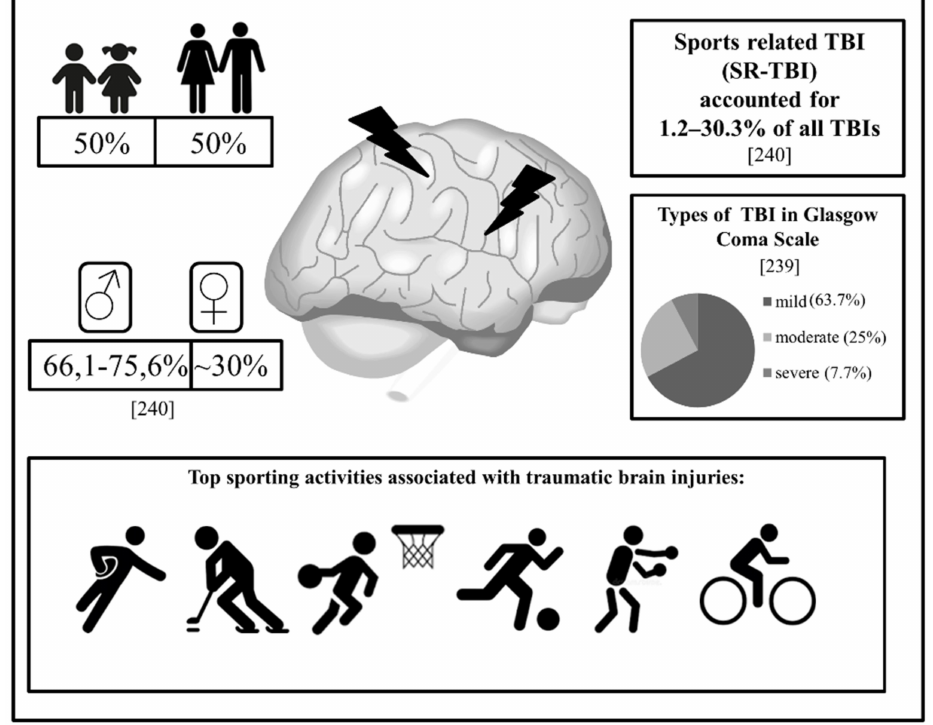
Figure 4. Summary of sports-related TBI causes and prevalence. Figure data obtained from